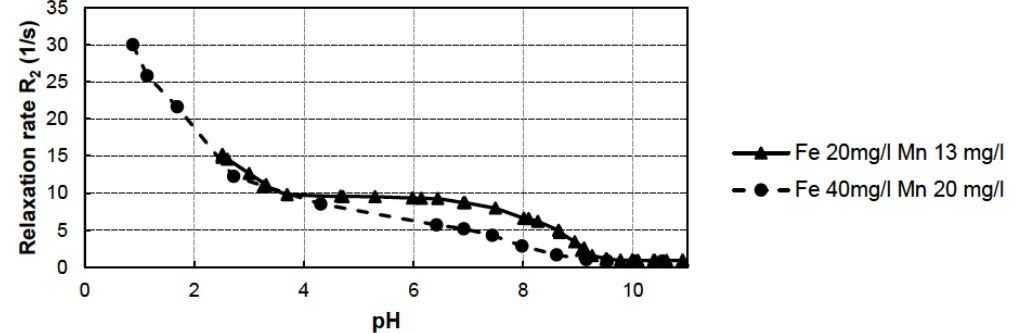
Figure 5: Relaxation rate R 2 results for two different mixtures of Mn 2+ and Fe 3+ as a function of pH.